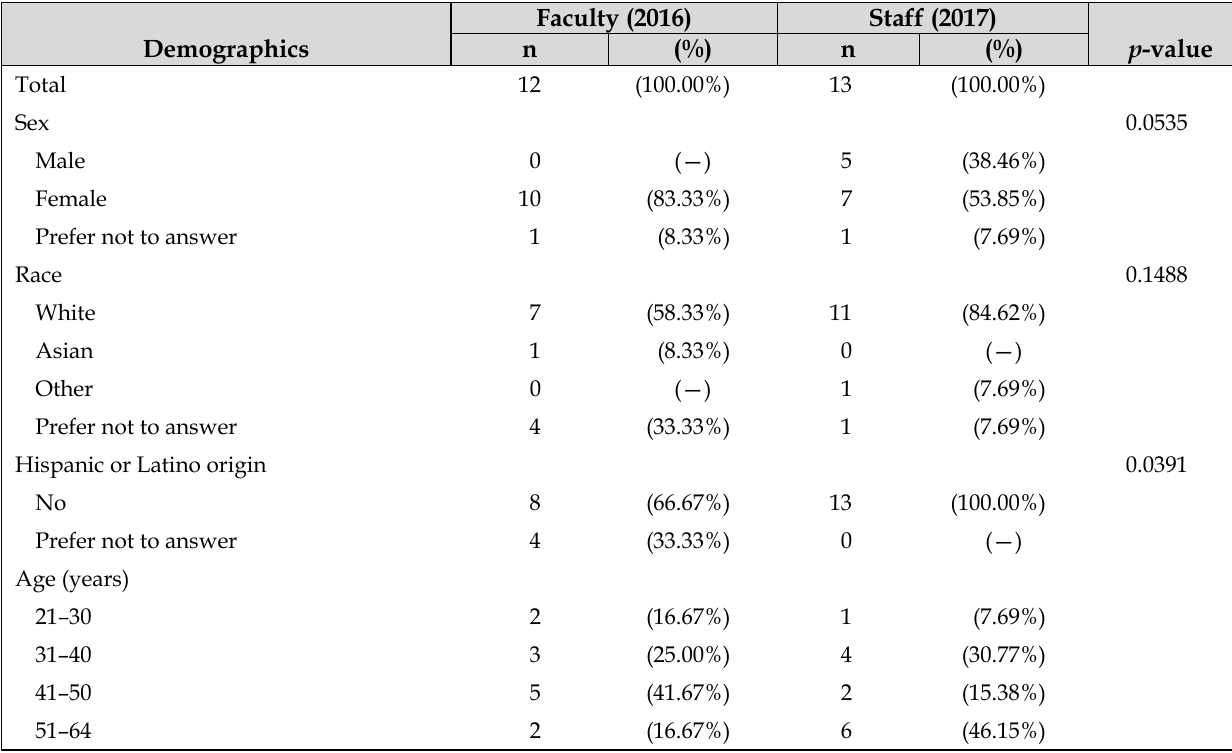
Table 1 Baseline demographics for faculty and staff